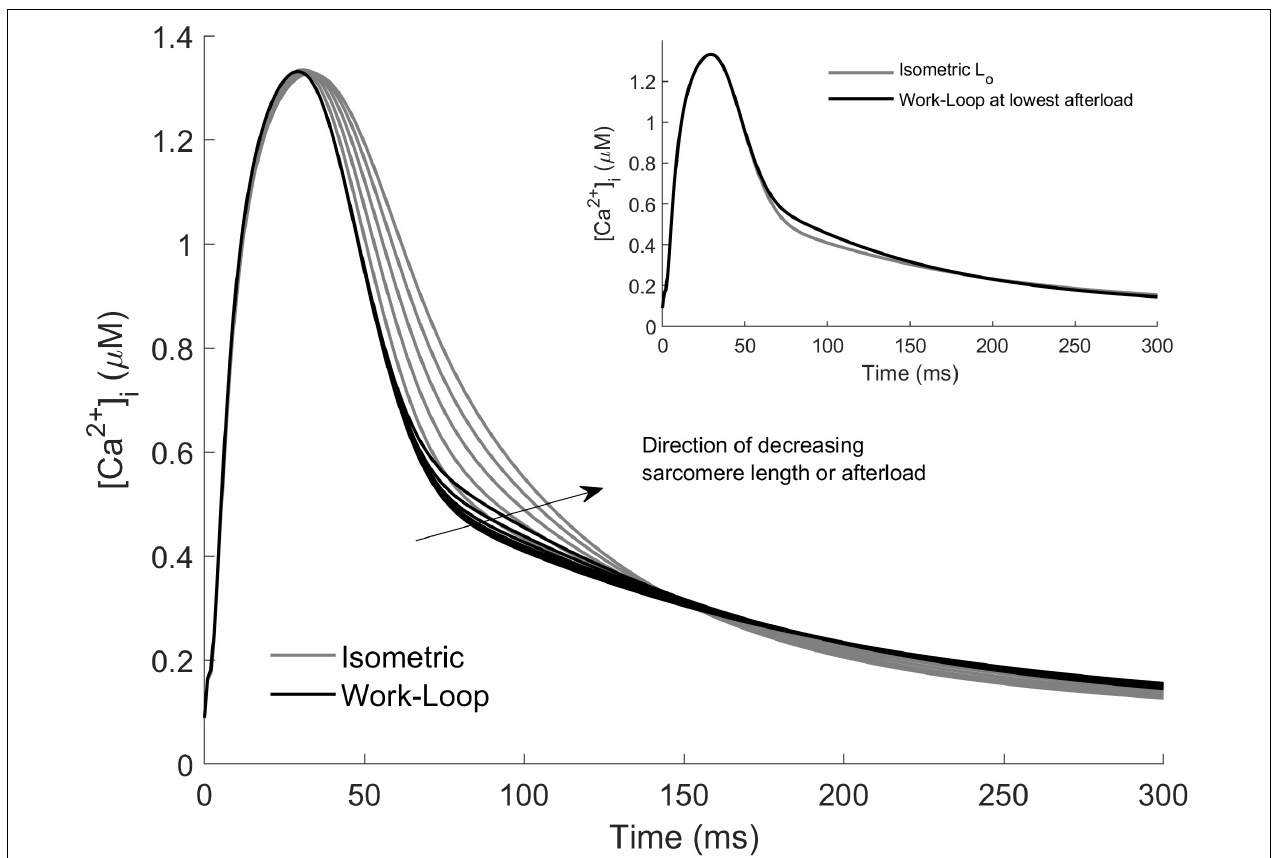
FIGURE 4 | Simulated Ca 2 + transients arising from isometric and work-loop contractions. Isometric contractions (gray) as functions of initial sarcomere length and work-loop contractions (black) as functions of afterload. The arrow indicates the direction of decreasing sarcomere length for the isometric simulations, and decreasing afterload for the work-loop simulations. Inset: Ca 2 + transients of the L o -isometric contraction (gray) and the work-loop contraction (black) at the lowest